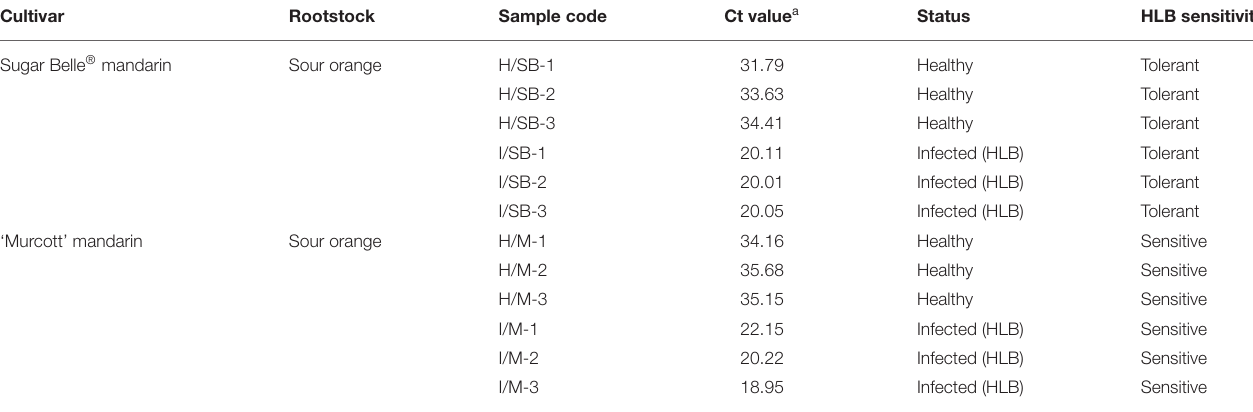
TABLE 1 | General information of HLB-tolerant and HLB-sensitive cultivars used in this study. Cultivar